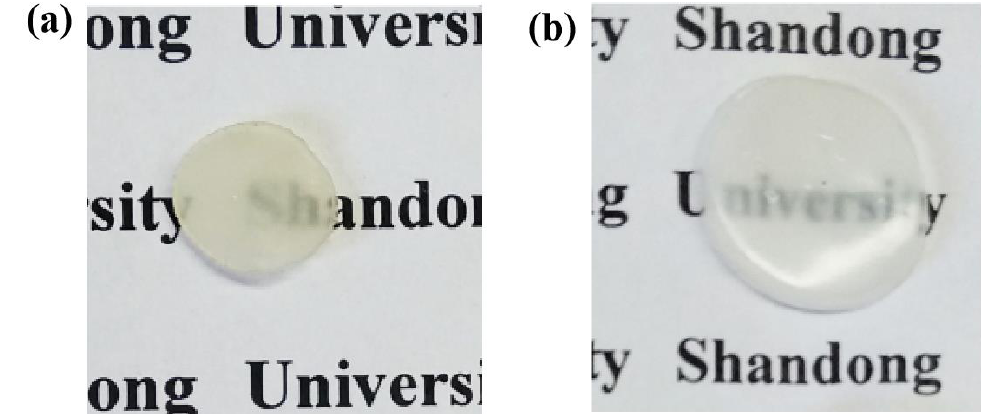
Figure 2. Comparison diagram of PAA gel film in water: ( a ) before and ( b ) after the swelling.